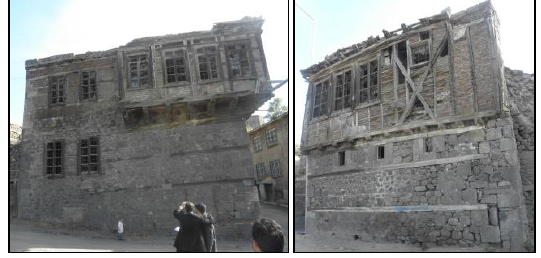
Figure 4.Usage of timbers and bricks